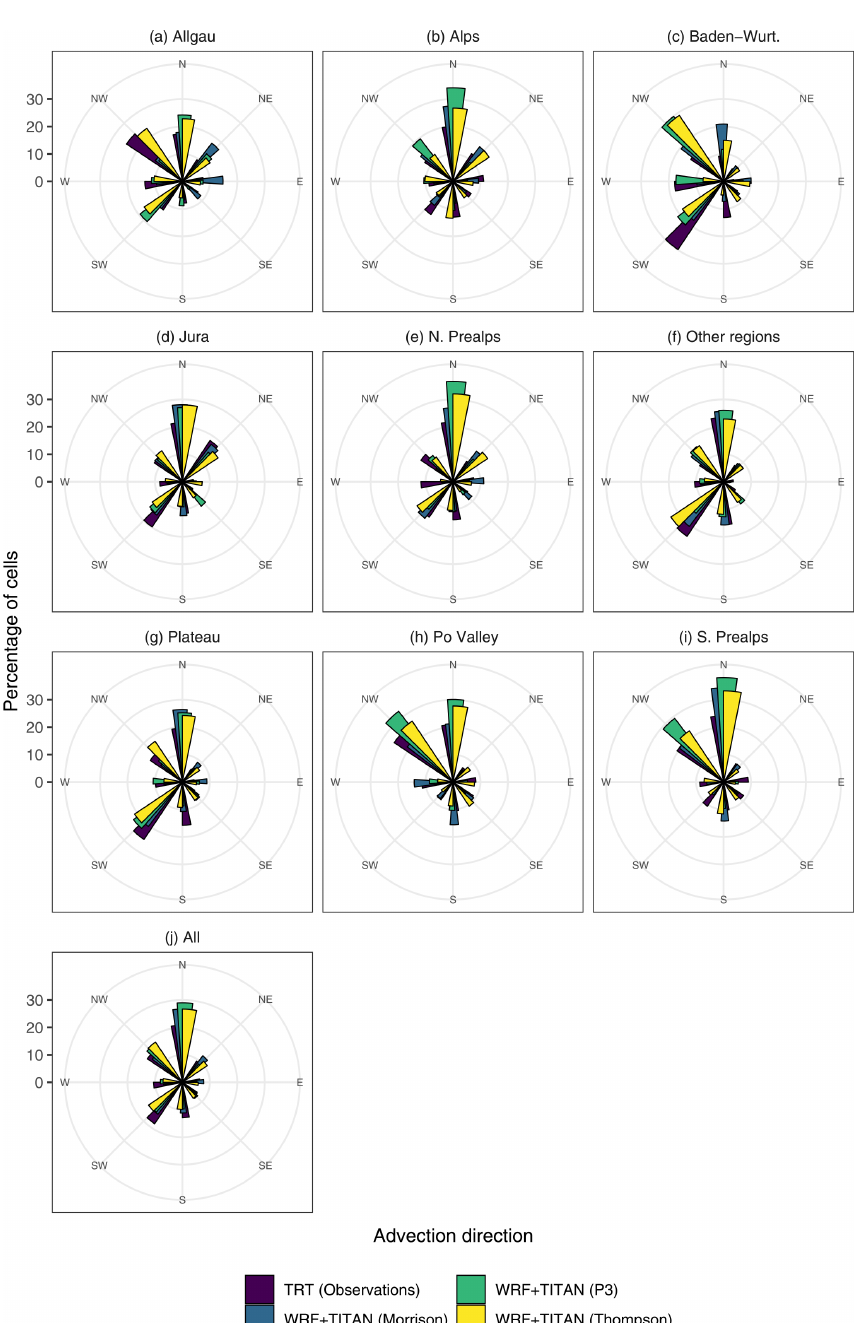
Figure 8. Comparison of tracked cell directions by TITAN (on WRF data) and TRT (on radar observations). Shown are the percentages of times cells that were detected as moving in each of eight compass directions by